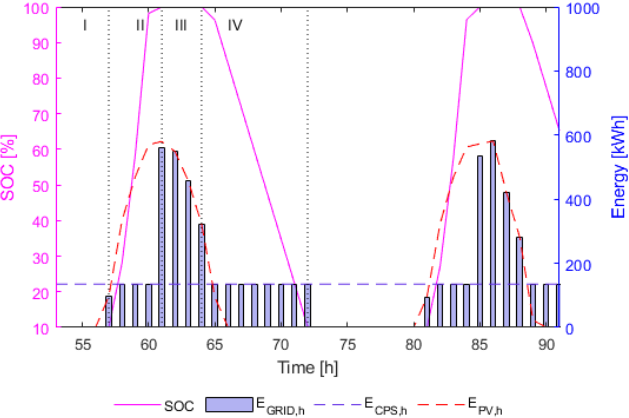
Figure 4. SOC evolution and energy balance in the BESS.